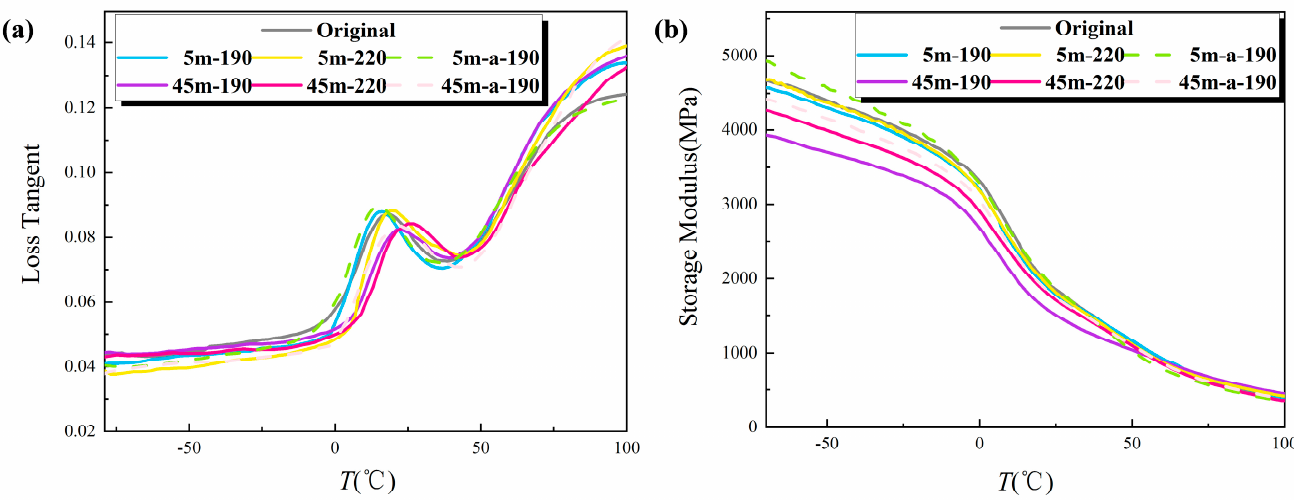
Figure 7. The dynamic relaxation atlas of samples. ( a ): Loss Tangent; ( b ): Storage Modulus.